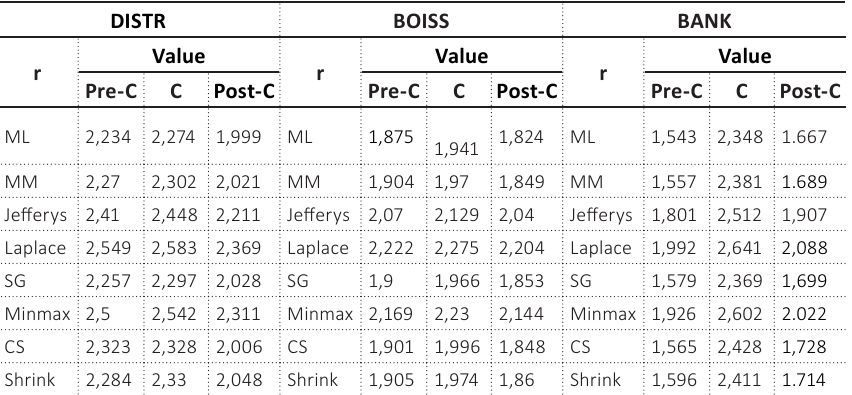
Table A2 (cont.). Different Shannon entropy measures of B&MC, P&G, MINES, AGRO, DISTR, BOISS, and BANK before the COVID-19 crisis (Pre-c), during the COVID-19 crisis (C), and after the COVID-19 crisis